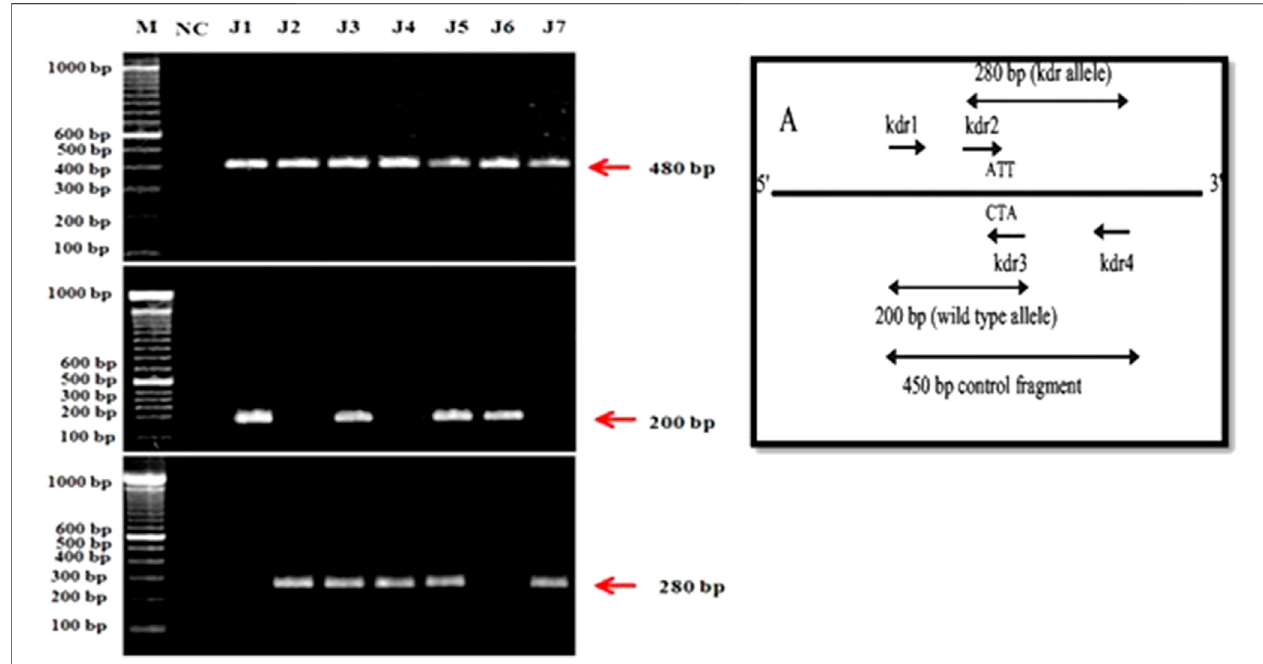
FIGURE1 | PCRampli fi cation ofhouse fl y, Muscadomestica L. Samples from District Jhang. (A) : kdr alleles. (B) : Acontrolfragment ampli fi ed using kdr1 and kdr4 primers. (C) : 200-bp susceptible allele fragment ampli fi ed kdr1 and kdr3. (D) : 280-bp kdr allele fragment ampli fi ed by kdr2 and kdr4.